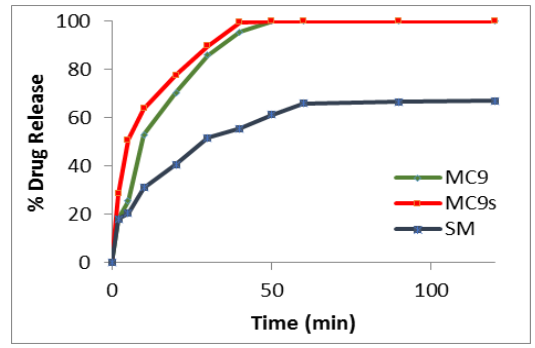
Figure (5) Dissolution profile of microcrystals MC9, MC9s, and untreated drug in phosphate buffer pH 6.8 at